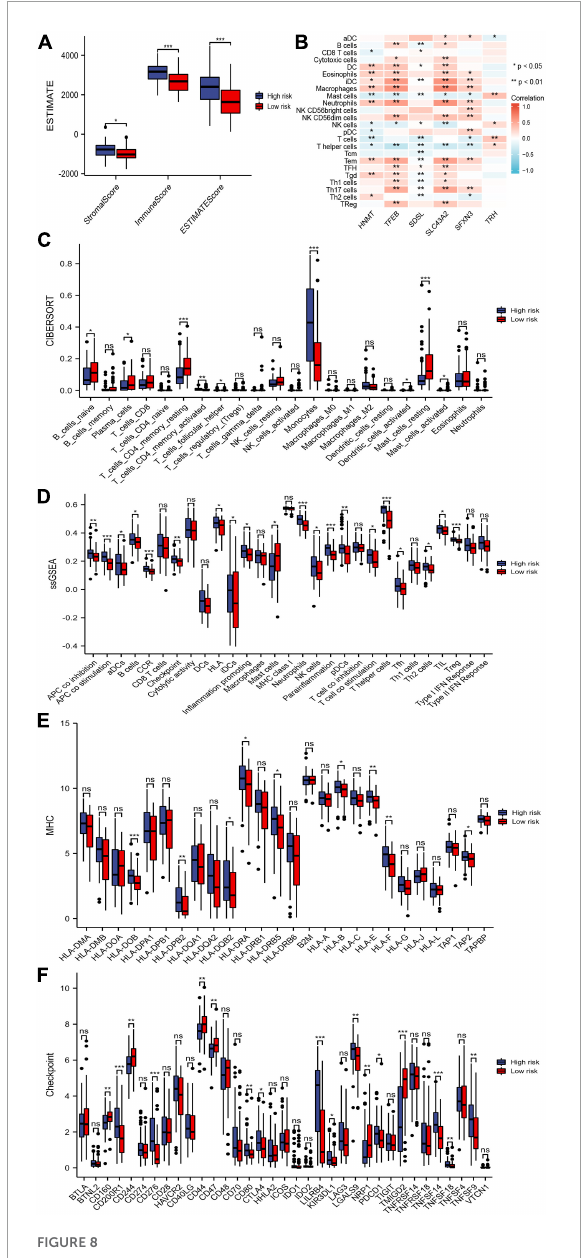
FIGURE8 Immune cells and immune-related genes between risk groups. (A) Stromal score, immune score, and ESTIMATE score between the risk groups. (B) The abundance of immune cells between the risk groups. (C,D) Immune cells and immune responses between the risk groups by the CIBERSORT and single-sample gene set enrichment analysis (ssGSEA) algorithms. (E,F) Boxplots of HLA-related genes and checkpoint-related genes in the risk groups. * p < 0.05, ** p < 0.01, *** p < 0.001, ns, no